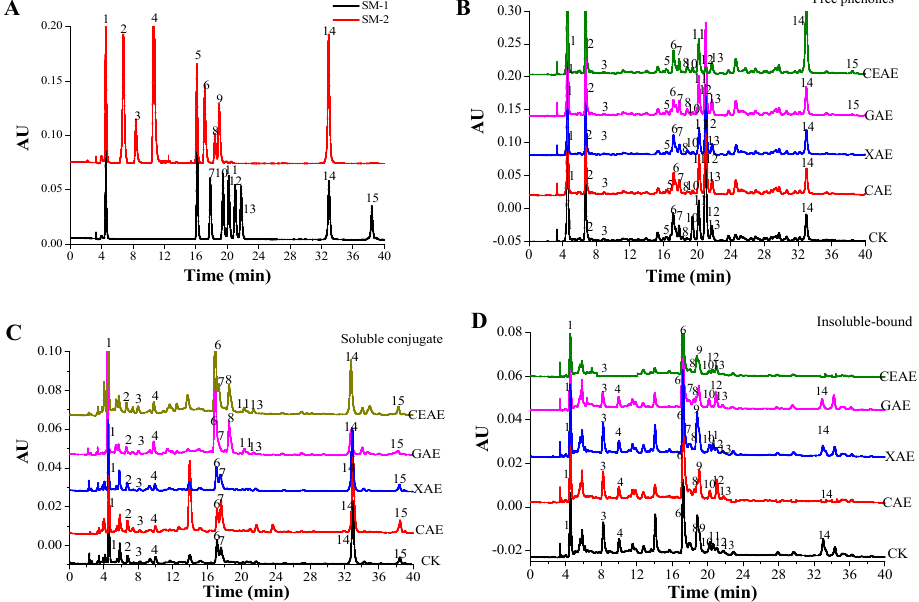
Figure 2. High performance liquid chromatography (HPLC) chromatogram of standard phenolics ( A ); free ( B ); soluble-conjugate ( C ); and insoluble-bound phenolics extracts ( D ) from guava leaves following different enzyme-assisted extraction methods. SM-1, standard mixtures of flavonoids; SM-2, standard mixtures of phenolic acids; CK, untreated; CAE, cellulase-assisted extraction; XAE, xylanase-assisted extraction; GAE, β -glucosidase-assisted extraction; CEAE, complex enzyme-assisted extraction. Peaks: 1, Gallic acid, 2, chlorogenic acid, 3, p -hydroxybenzoic acid, 4, caffeic acid, 5, rutin,